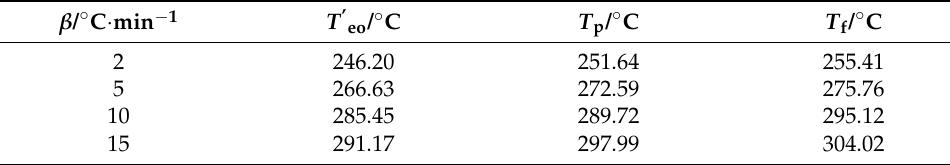
Figure 3. DSC curves for DFTANA at different heating rates of 2, 5, 10 and 15 ◦ C min − 1 . Table 2. DSC data of DFTNAN at different heating